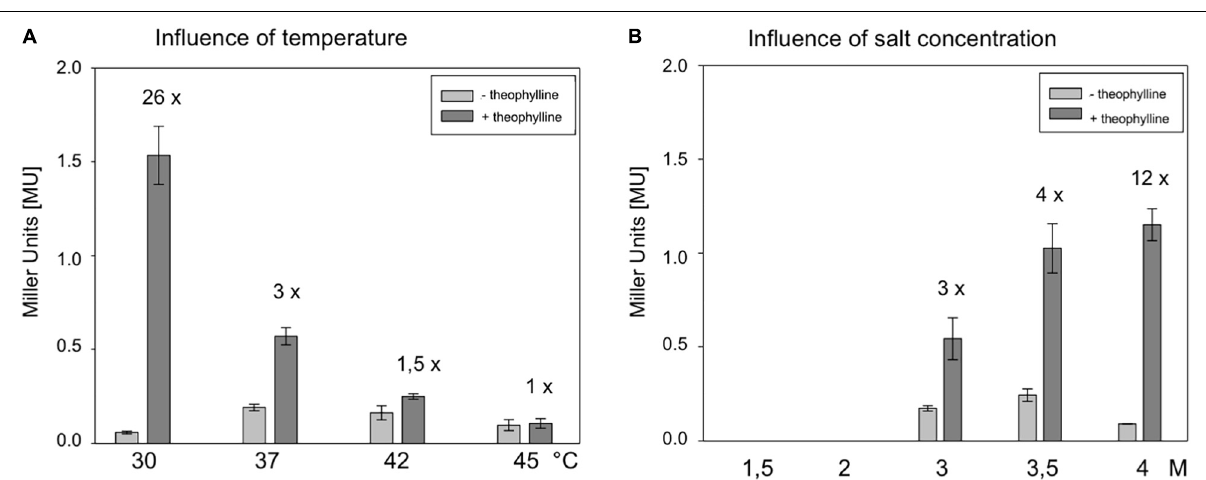
only 3- or 4-fold. In contrast, RE transformants grown in